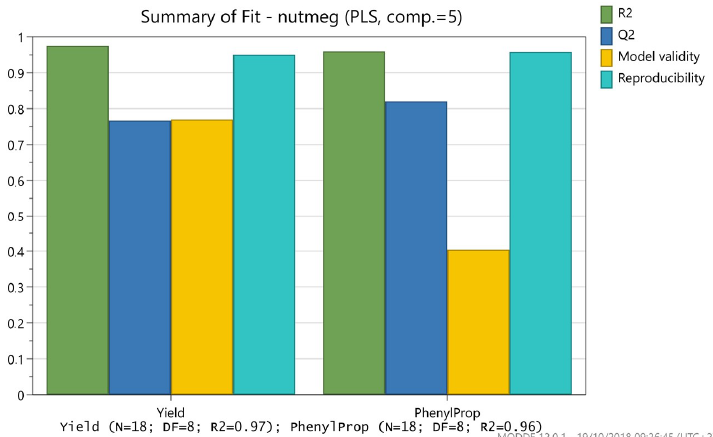
Figure 2. Summary of fit for the model of extraction yield and phenylpropanoids percentage. PLS: partial least squares fitting.